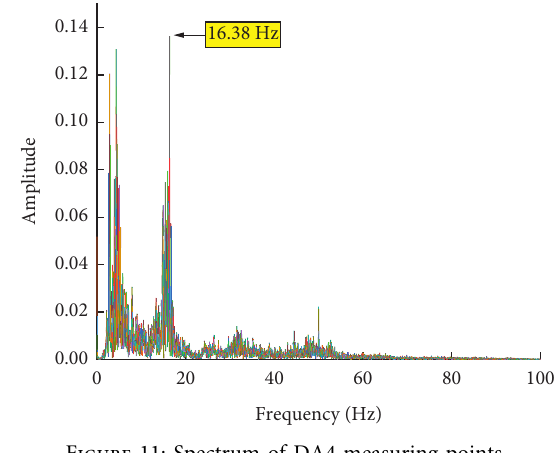
Figure 11: Spectrum of DA4 measuring points.